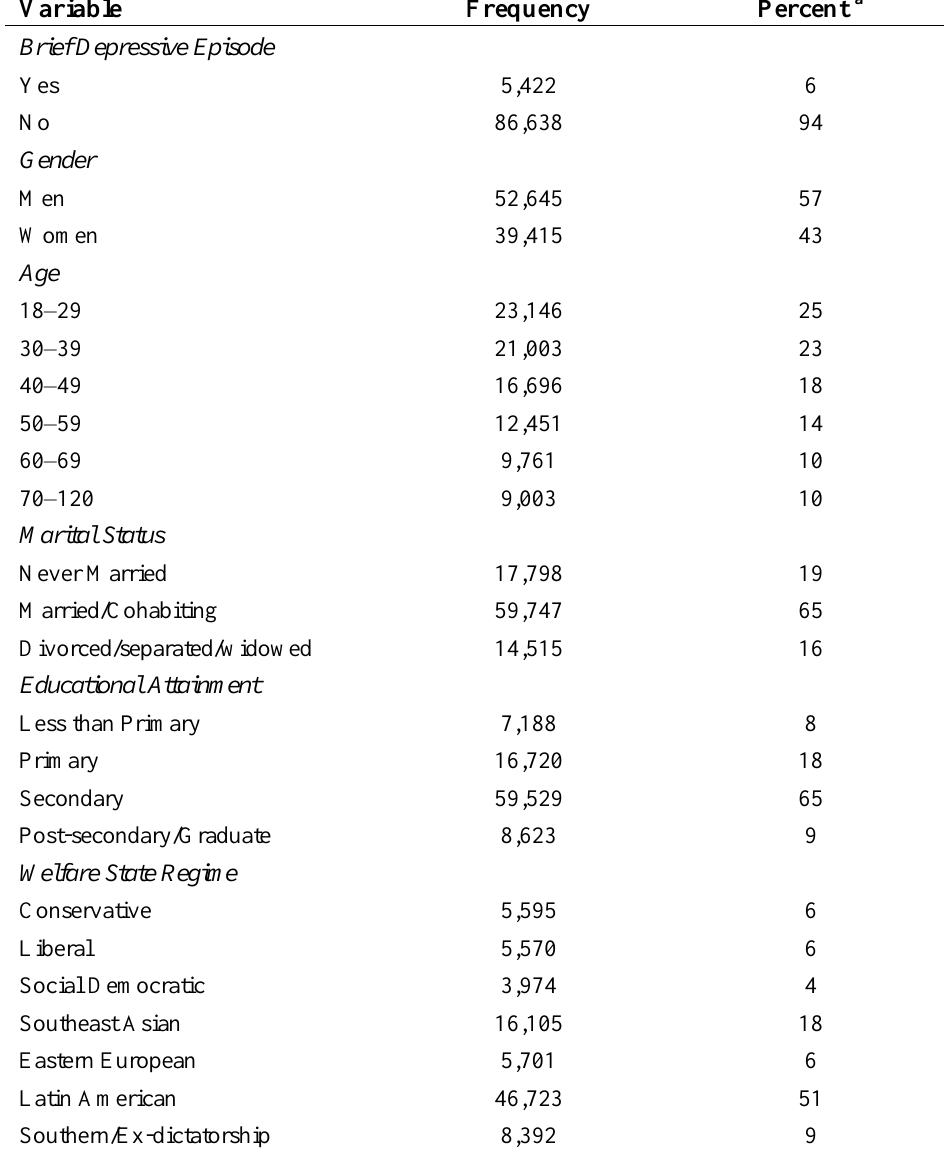
Table 2. Sample description.